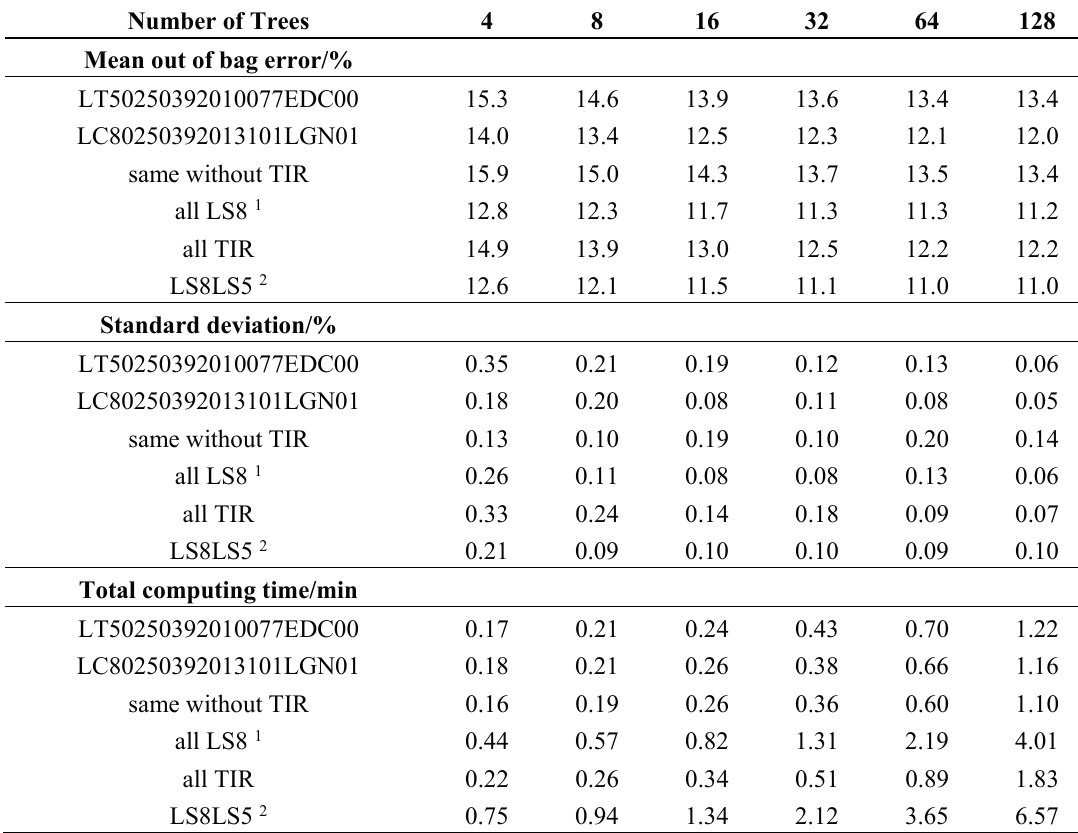
Table 2. Mean and standard deviation of out of bag error from five classifications in % and sum of computing time in minutes for Houston using different numbers of trees and feature sets. Feature sets: LT50250392010077EDC00 and LC80250392013101LGN01 refer to a single Landsat (LS) 5 and LS 8 scene, respectively, same without TIR : LS8 without thermal infrared bands, all LS8 : five LS8 scenes, all TIR : thermal bands from LS8LS5 , LS8LS5 : LS8 plus six LS5